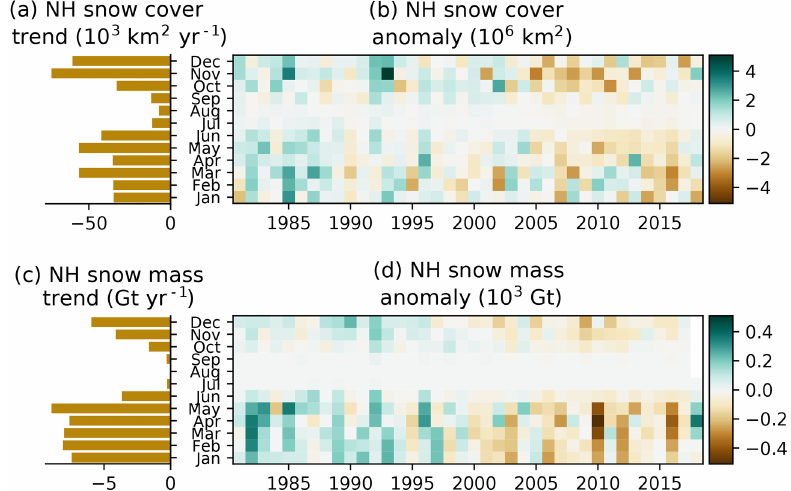
Figure 1. Observation-based NH snow extent (a, b) and snow mass (c, d) trends (a, c) and anomalies (b, d) for January 1981 through December 2018 relative to 1981–2014.